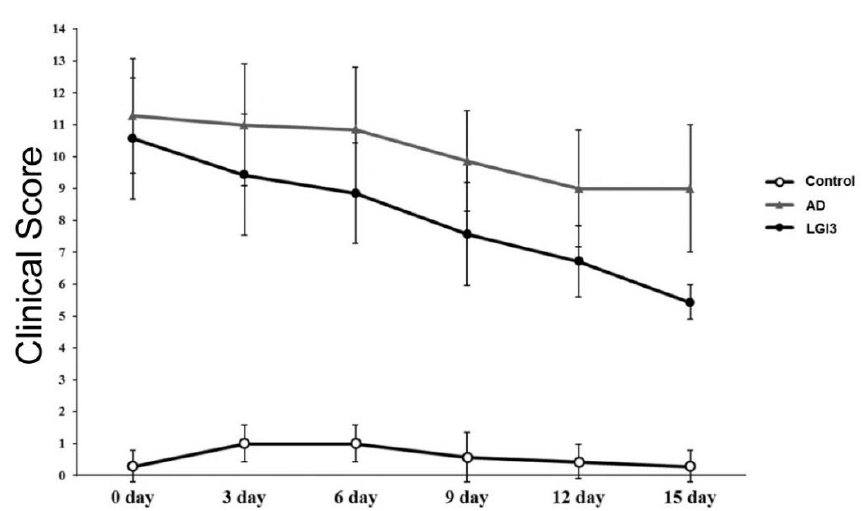
Figure 5. Clinical score of atopic dermatitis (AD) skin lesions from each group of mice (n = 7). On day 15, elevated scoring atopic dermatitis (SCORAD) Index was observed in the AD group (9 ± 2 score) compared to the control group. Treatment with the leucine-rich glioma inactivated 3 (LGI3) reversed this change (5.43 ± 0.53 score). Data are expressed as mean ± S.D. Statistical analysis was performed using